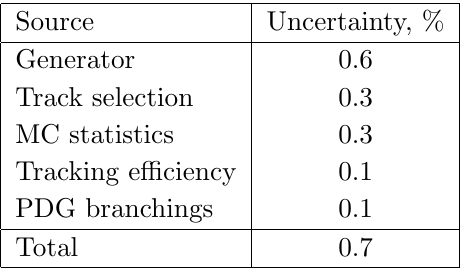
Table 5 . Systematic uncertainties of (cid:0) ee ( J= ) (cid:1) B hadrons ( J= ) due to imperfect simulation of J= decays.